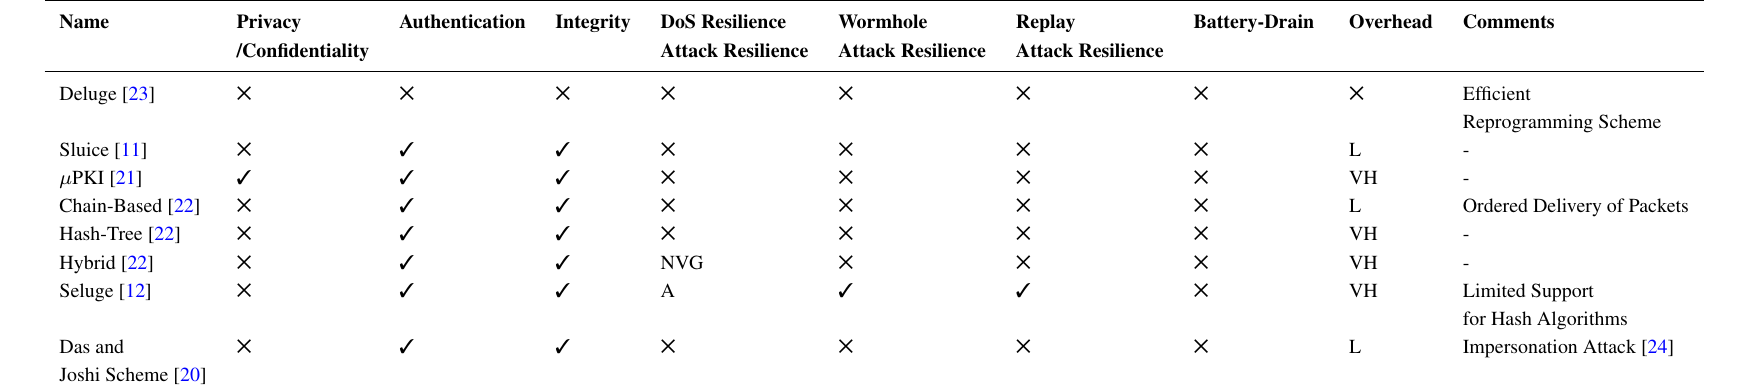
Table 1. A summary of the existing security models for the the over-the-air programming (OTAP)